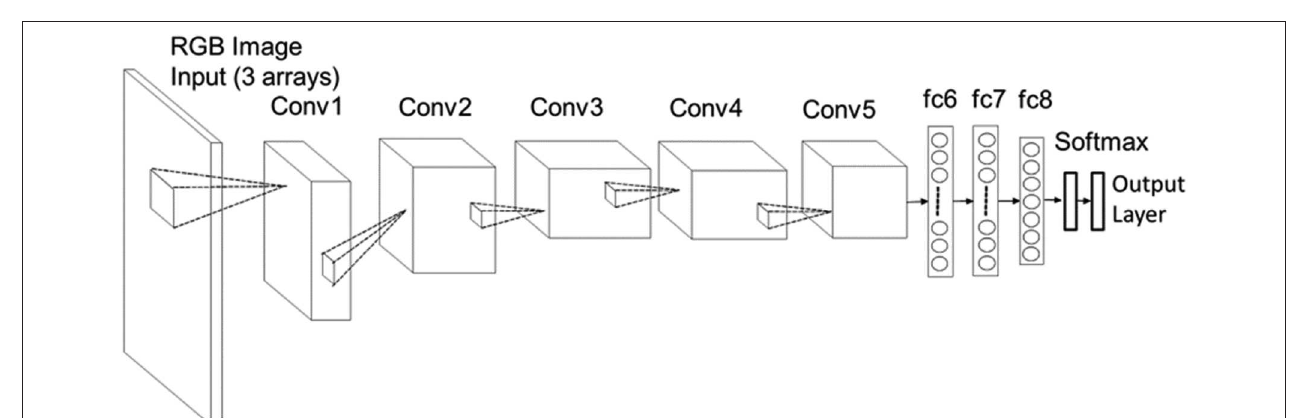
three color-component arrays ( Figure 7 ). As shown in Lech et al. (2018) the RGB images show slightly higher SER performance compared to the gray-scale images. The transformation into